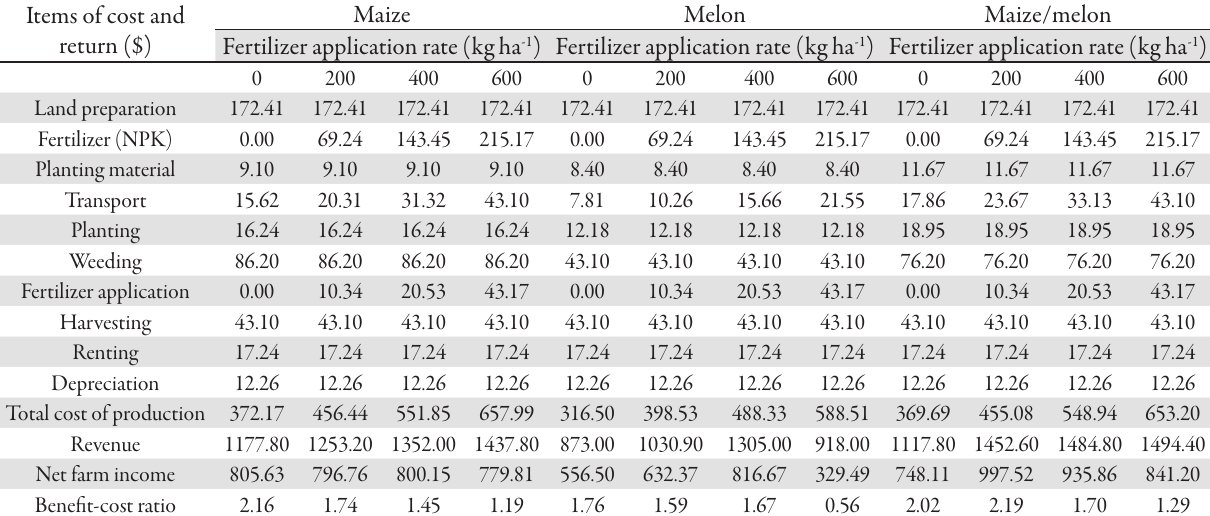
Tab. 4. Profitability analysis of maize and melon from sole maize/melon mixed cropping systems Items of cost